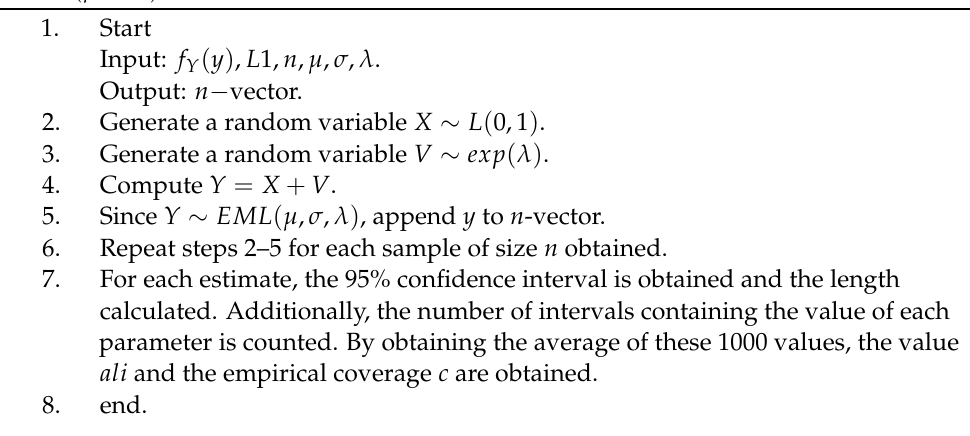
Algorithm 1: Monte Carlo algorithm to generate random numbers from the